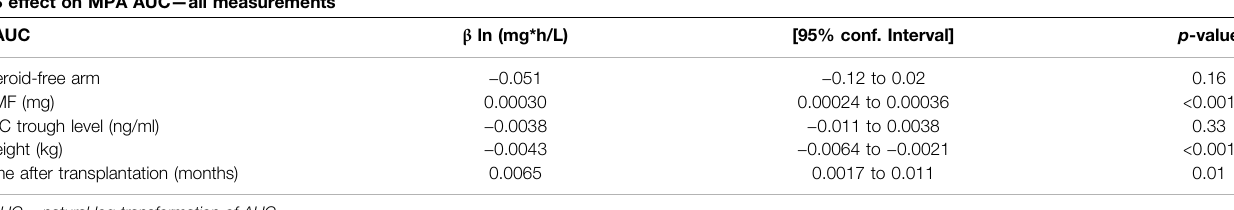
TABLE 2 | Multilevel mixed-effects linear regression based on all available MPA AUC measurements ( n (cid:1) 531). CS effect on MPA AUC — all measurements